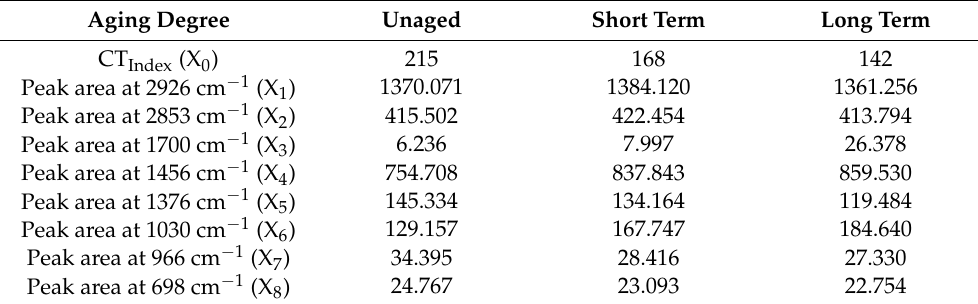
Table 6. Grey correlation data between CT Index and different peak areas (LFSMA-13).